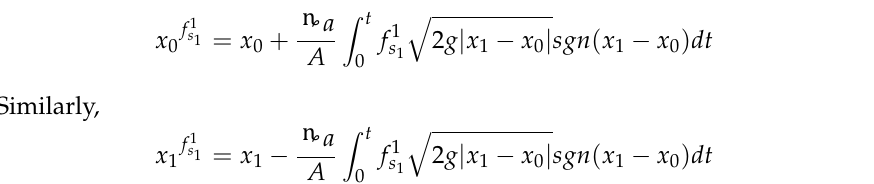
Figure 1. Three-pond hydraulic system.